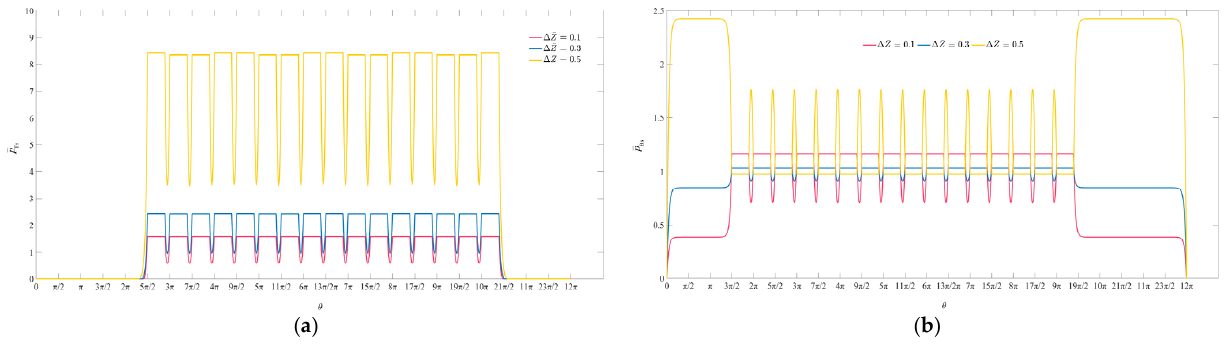
Figure 4. The variations of the steady pressures in the θ direction. ( a ) P Ts ; ( b ) P Bs . There is a mixture of Couette flow and Poiseuille flow in this research [34]. The motion of the screw relative to the nut brings the Couette flow. Poiseuille flow exists not only between a chamber and the adjacent sealing surface, but also between adjacent oil chambers. When the clearance thickness is small, the Couette flow is dominant to maintain the pressures constant among different oil chambers, such as when ∆ Z = 0.1,